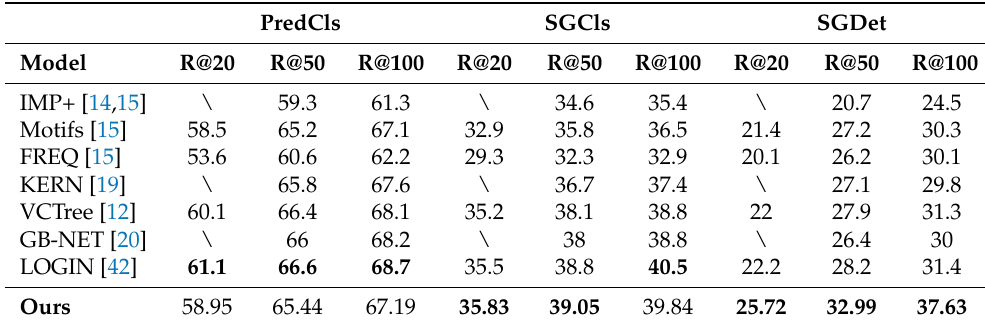
Table 2. Comparison of the R@20, R@50, and R@100 metrics in % between our model and existing works. (Since the original paper lacks some results, the IMP+ results use the corresponding data presented in